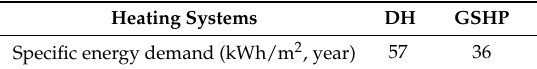
Table 5. Specific energy demand for the different system variations without solar energy system.